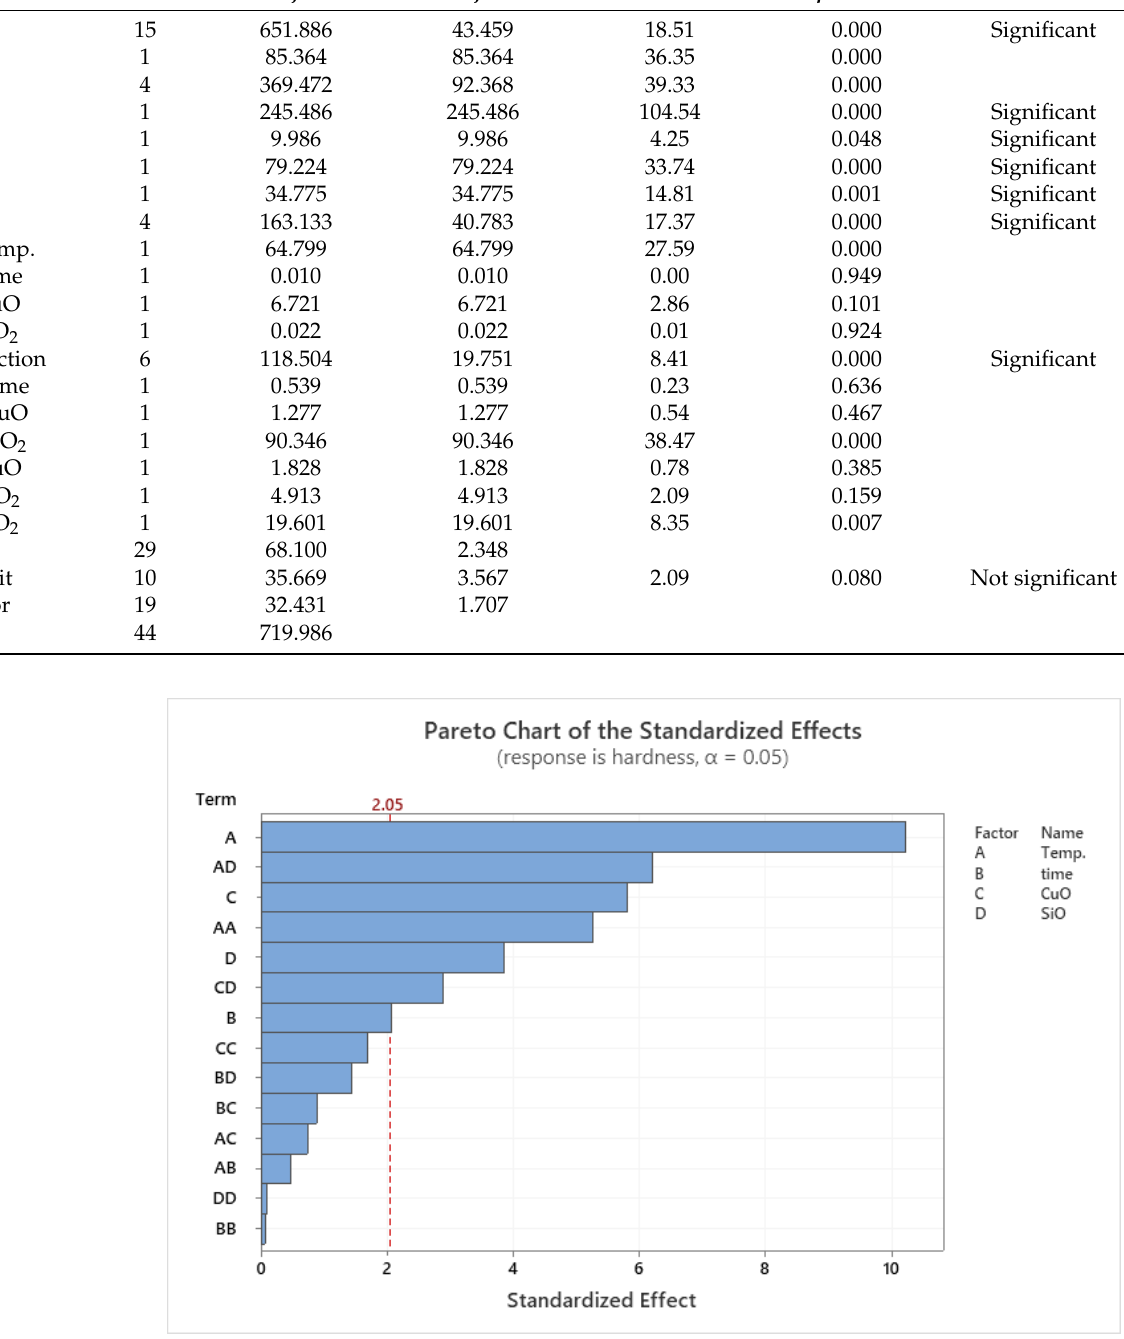
Figure 11. Pareto chart of the standardized effects for microhardness. Table 8. R value for microhardness by